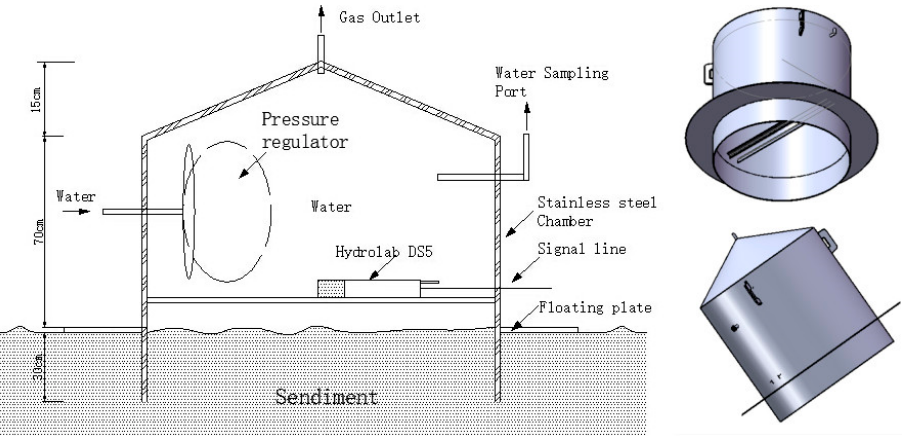
Figure 3. Schematic of the in situ experimental chamber.